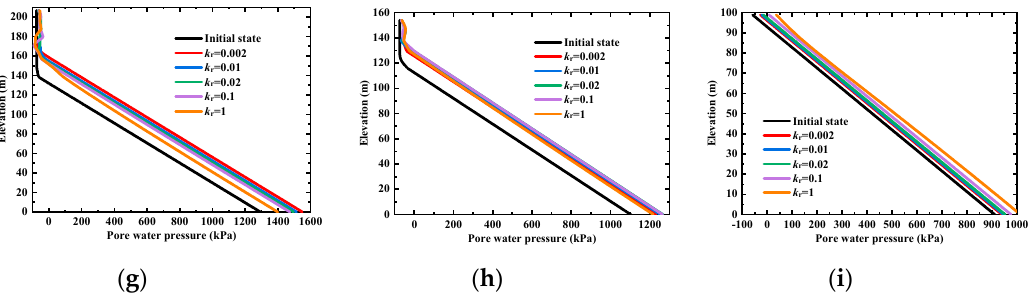
Figure 12. Pore water pressure levels at different positions on the layered rock slope under different k r values with β = 0, β = 30, and β = 90°: ( a ) Top of the slope with β = 0°; ( b ) middle of the slope with β = 0°; ( c ) bottom of the slope with β = 0°; ( d ) top of the slope with β = 30°; ( e ) middle of the slope with β = 30°; ( f ) bottom of the slope with β = 30°; ( g ) top of the slope with β = 90°; ( h ) middle of the slope with β = 90°; ( i ) bottom of the slope with β = 90°.